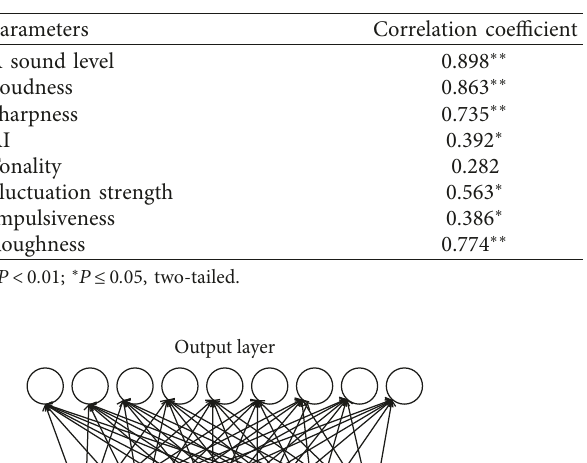
Table 1: Correlation between psychoacoustic parameters and evaluation score.